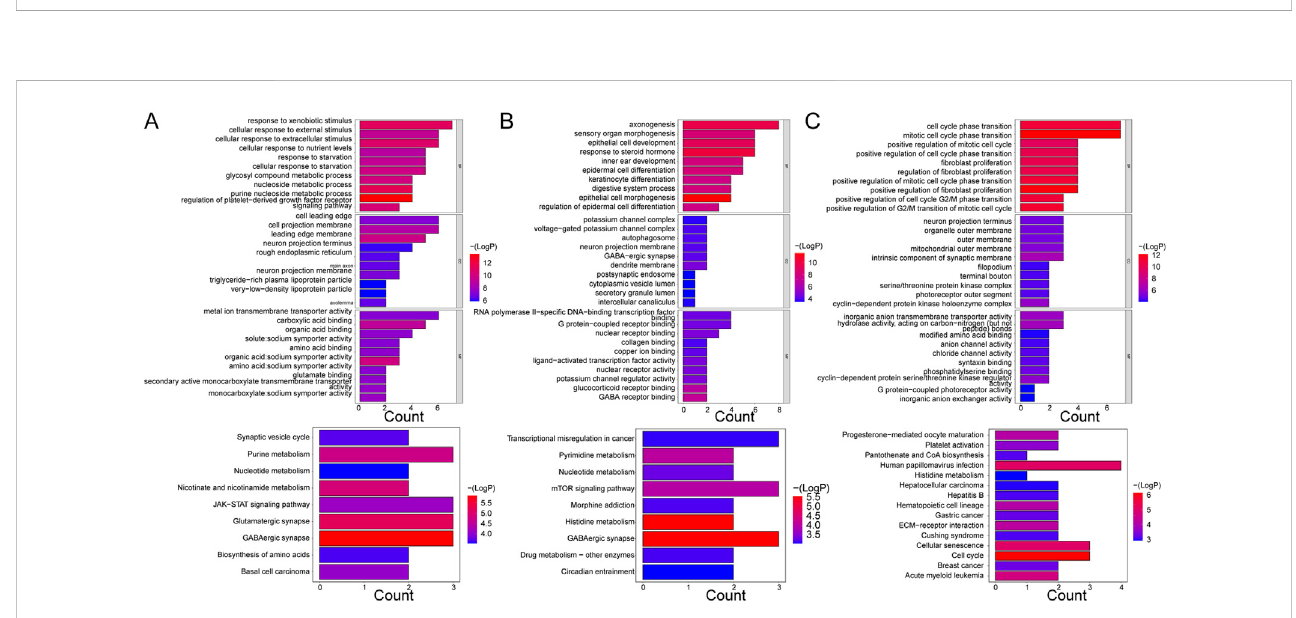
FIGURE 4 GO enrichment and KEGG pathway analyses of mRNAs enrolled in ceRNA networks. (A) KEGG pathway and GO enrichment analysis of mRNAs in the ceRNA(lncRNA)networkincontrolandcasegroups. (B) KEGGpathwayandGOenrichmentanalysisofmRNAsintheceRNA(lncRNA)networkinthecaseand treatment groups. (C) KEGG pathway and GO enrichment analysis of mRNAs in the ceRNA (lncRNA) network in the control and treatment groups. Each GO map shows the top 10 enrichedphrases in BP, CC, and MF. On (A, B) , thetop 9enrichedKEGG pathwaysare shown, while (C) shows thetop 15 enriched KEGG